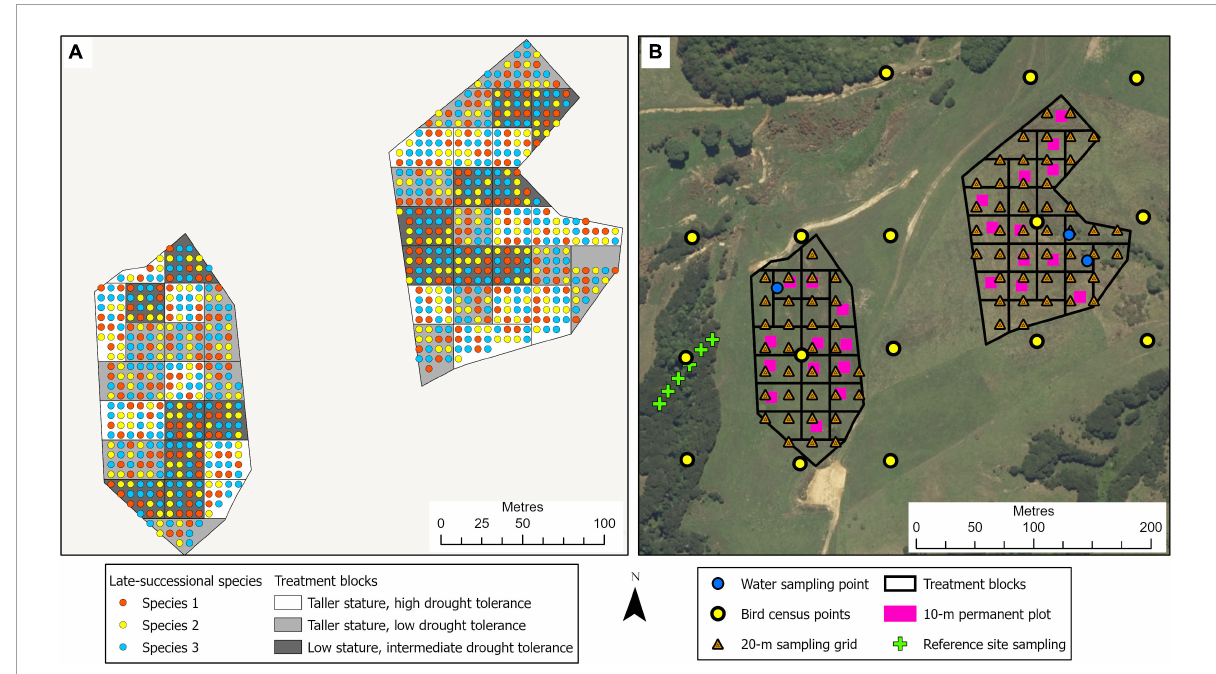
FIGURE5 Illustration of the tree planting, treatment block, and site monitoring design for the P¯ukorokoro experimental site. (A) The treatments involve three mixtures of native nurse tree species, comprising differences in stature and drought tolerance, planted at 1.5-m spacing; across the site, four late-successional canopy species are planted singly at a 6-m spacing, in a randomized design (see Tables 1 , 2 ). Survival and performance of both target and nurse tree species are monitored through time. (B) Monitoring design, at the landscape scale (e.g., bird observations, water quality), at the treatment block scale, within 10 × 10-m permanent plots (e.g., decomposition, natural seedling recruitment), and at the 20-m sampling grid scale (e.g., soil chemistry, soil